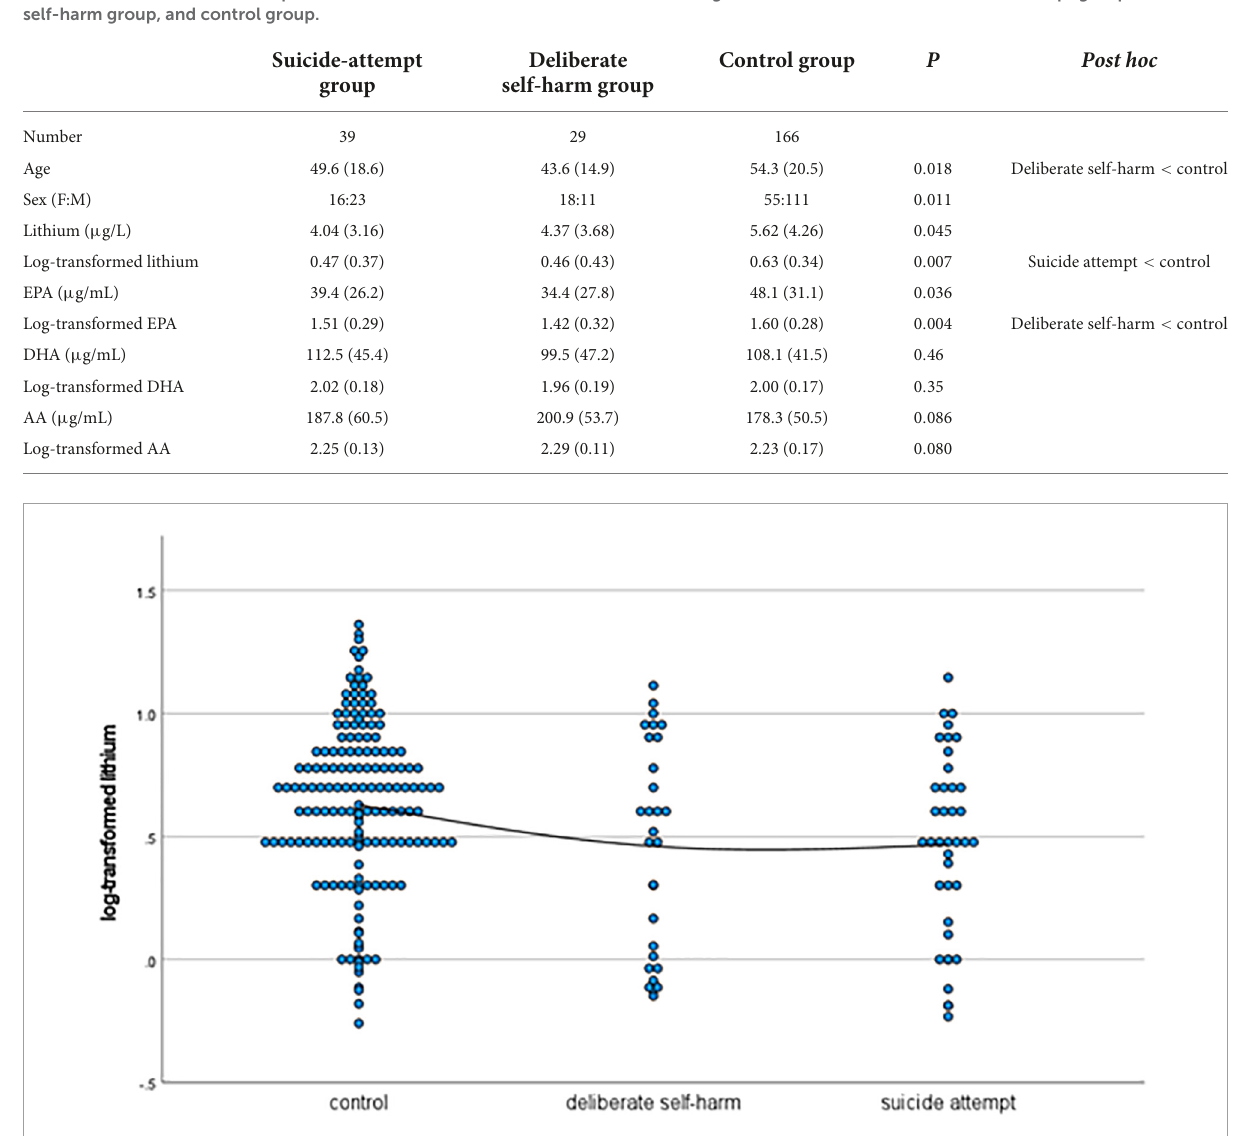
FIGURE1 Scattergram of log-transformed lithium levels in the control, deliberate self-harm, and suicide-attempt groups.